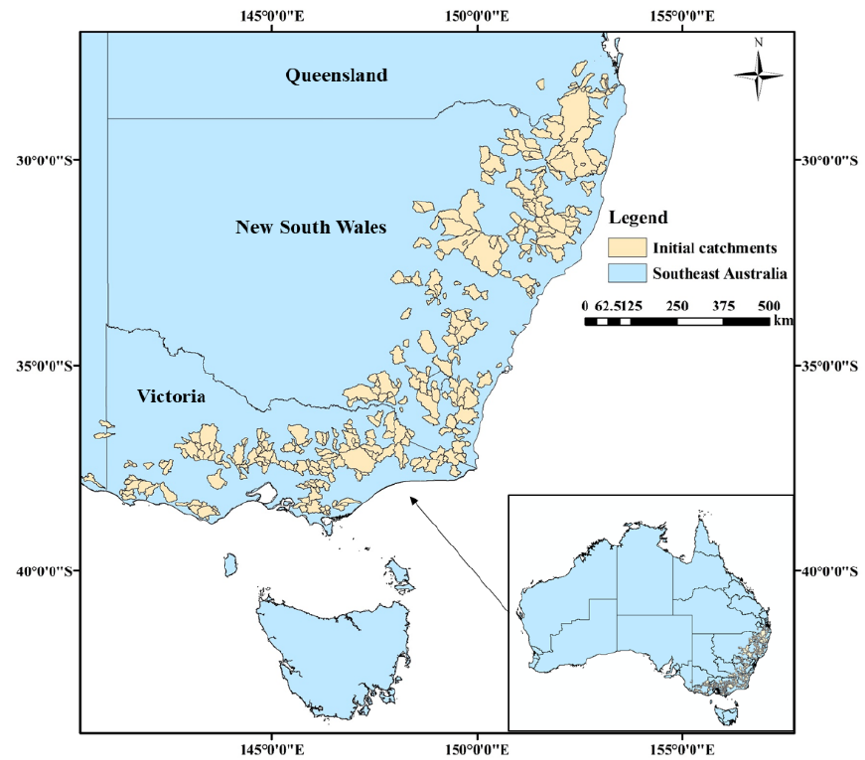
Figure 1. Spatial distribution of the original 398 catchments in southeastern Australia that were selected from Zhang et al.